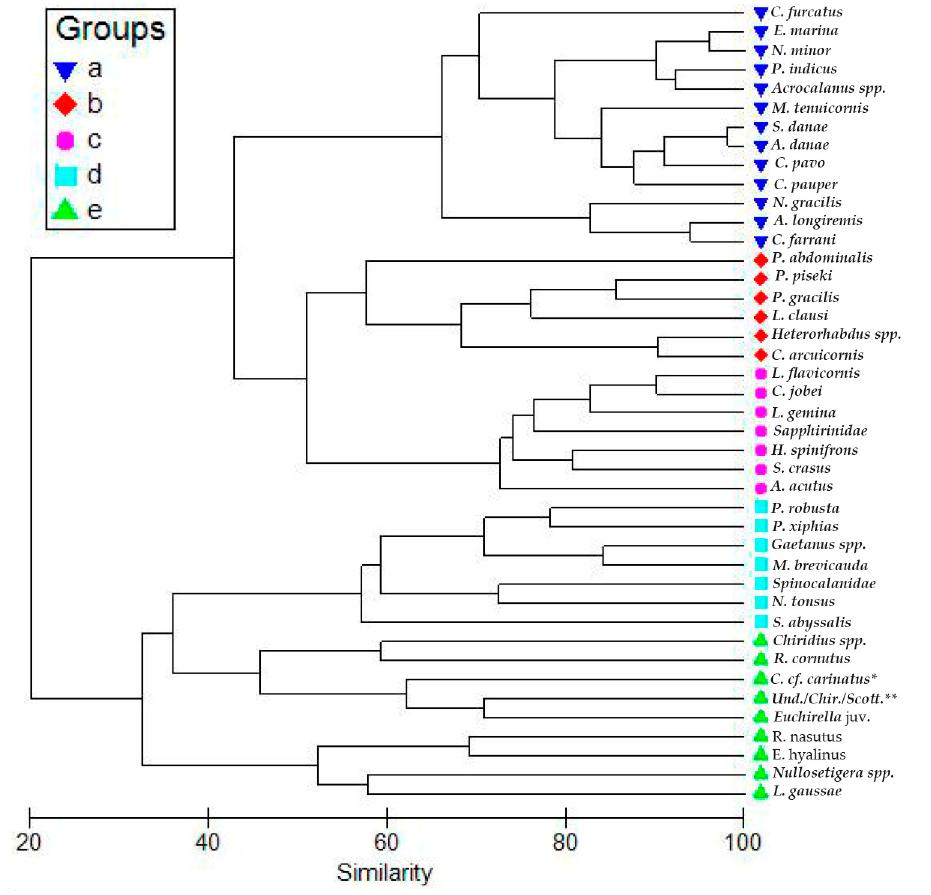
Figure 7. Cluster analysis of main copepod species found (log x + 1) in the zooplankton stations using Bray-Curtis similarity. * C . cf carinatus from the eastern Atlantic recently re-described [50].** Undeuchaeta (Und), Chirundina (Chi) and Scottocalans (Scott) were joined as a group due to the high similarity.